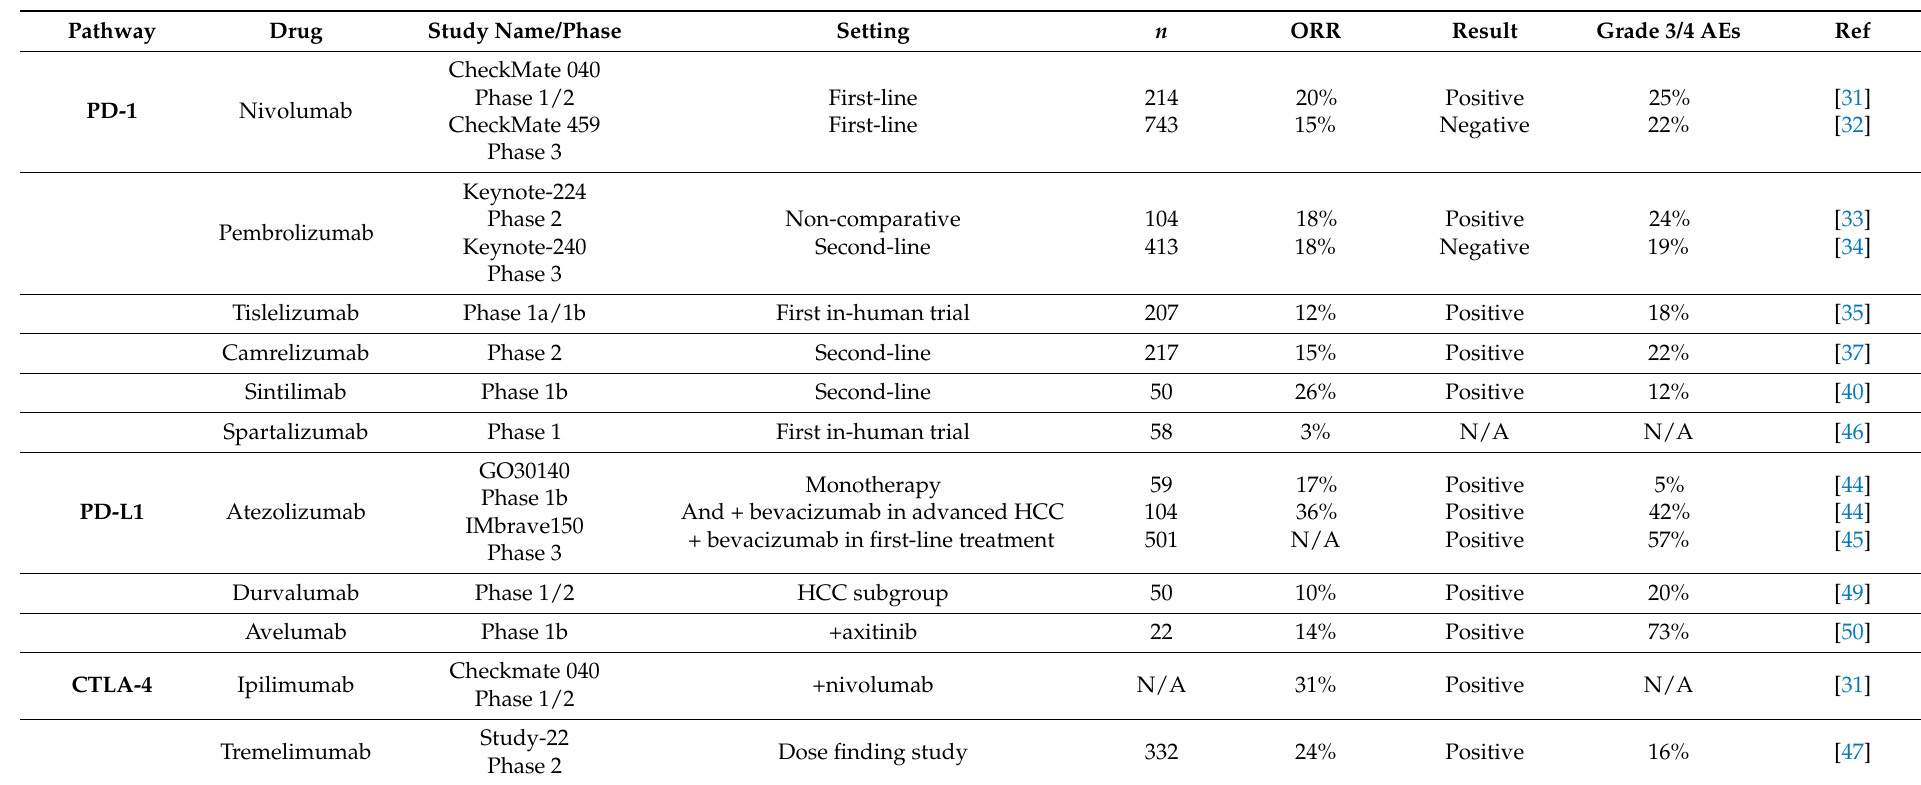
Table 1. Publicized studies of approved immune checkpoint inhibitors, monotherapy and combinational therapy, in HCC, displaying results and adverse events. Pathway Drug Study Name/Phase